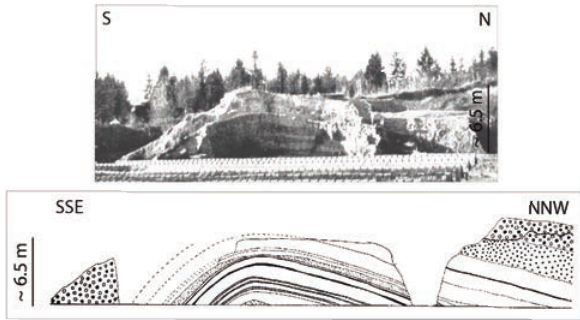
Figure 4. Picture and profile of an asymmetric anticline in Quater- nary sediments in former Lokarje clay pit [Šifrer 1961]. See Figure 2 for location. The orientations of picture and the profile are inferred from the clay pit map in Šercelj [1961]. An approximate vertical scale is in- ferred from the description of the thicknesses of sediment layers in the